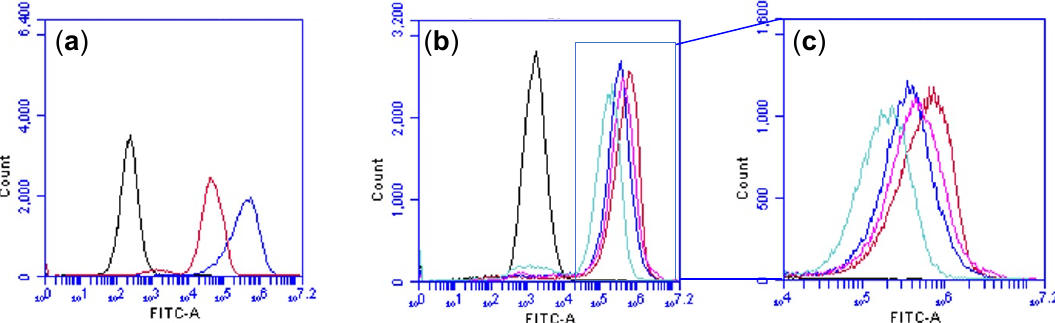
Figure 6. ( a ) FACS histogram showing BODIPY 493/503 fluorescence in ATCC 20509 samples collected after 18 h (red line) and 90 h (blue line) of the process in WPYE. Black line = unstained. ( b ) FACS histogram showing BODIPY 493/503 fluorescence in sample collected at 26 h (light blue line), 55 h (blue line), 75 h (pink line), and 90 h (red line) of the process in WPYEU. Black line = unstained. ( c ) Zoomed-in view.